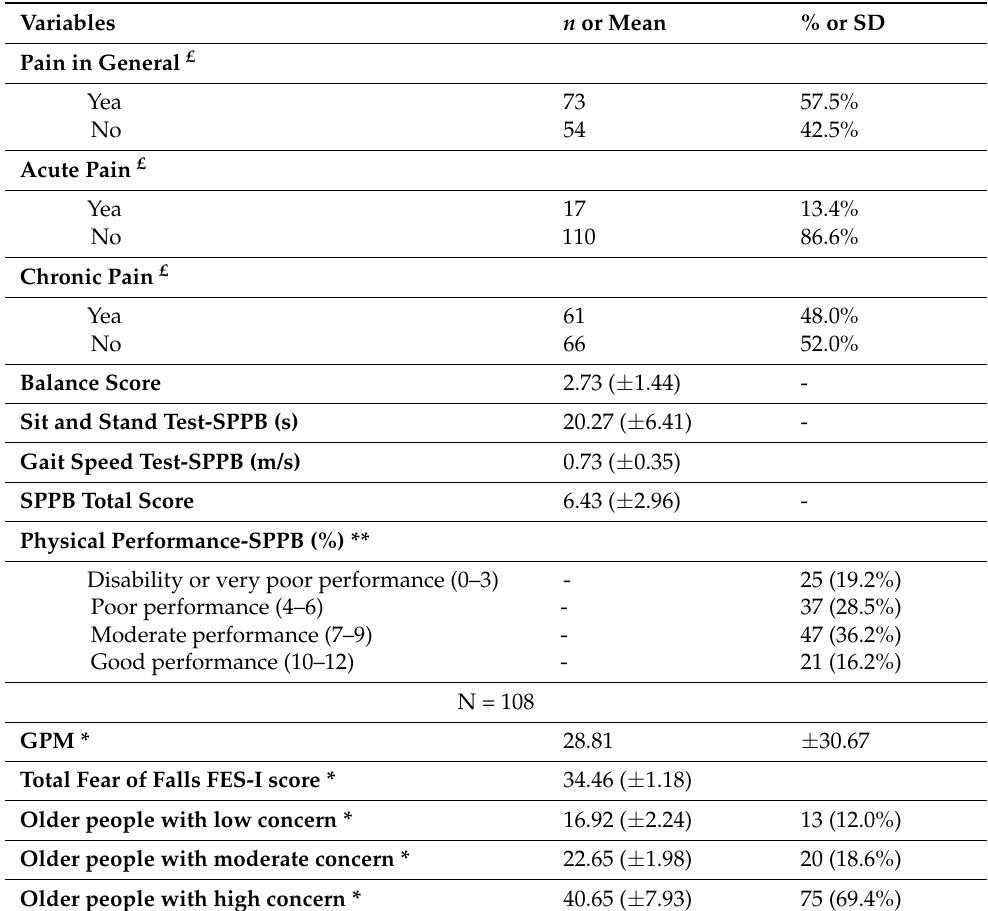
Table 2. Characterization of pain, fear of falling and physical performance Natal-RN, 2016 ( n = 133).